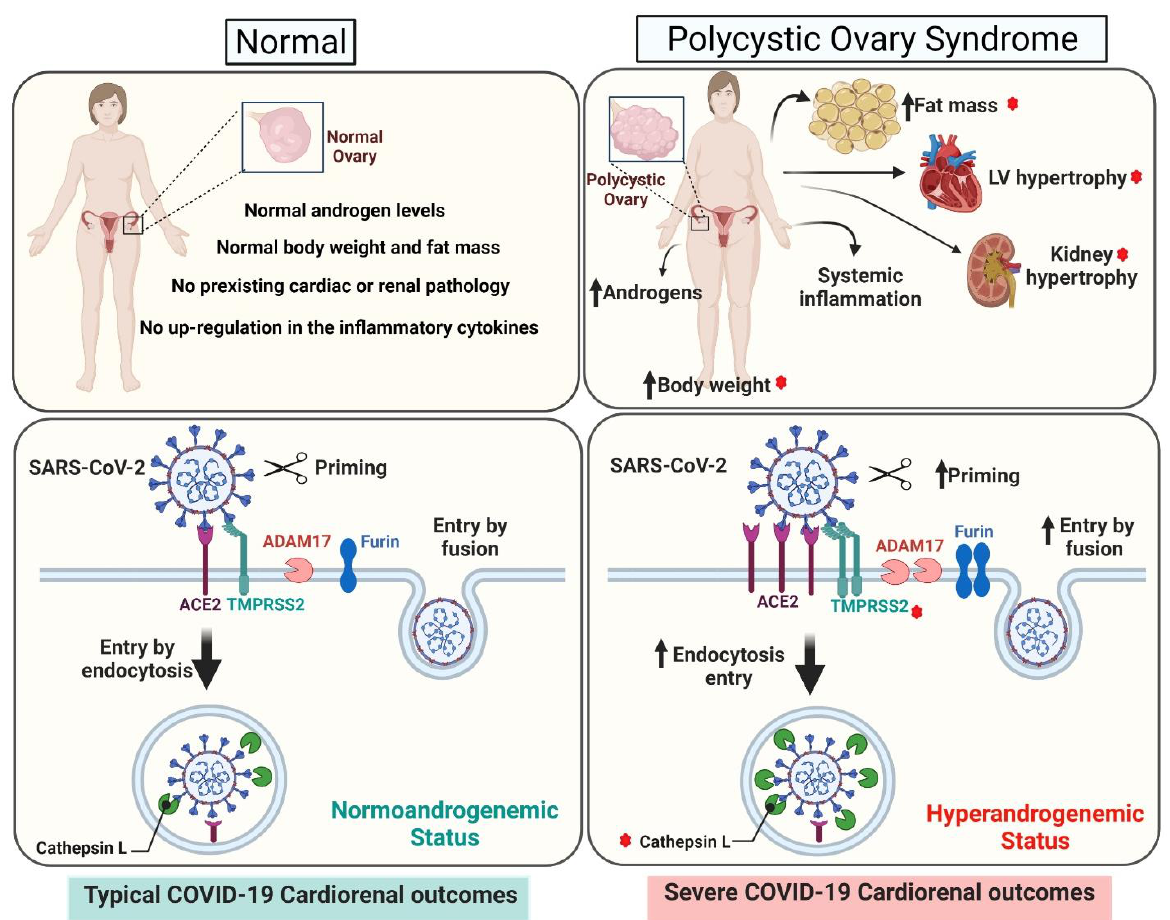
Figure 7. Proposed mechanisms for increased risk for severe COVID-19 cardiorenal outcomes in normal women and women with PCOS. Top panels: Women with PCOS have increased body weight, fat mass, and cardiac and renal hypertrophy. Lower panels: Androgens differentially regulate the cardiac and renal expression of SARS-CoV-2 viral entry proteins including the SARS-CoV-2 receptor ACE2 and several cellular proteases that promote viral entry and propagation. HFD exacerbates androgens-mediated obesity and cardiorenal hypertrophic response and modulates androgens’ effect on the expression of the different cellular proteases. The red stars indicates the parameters that are exacerbated with HFD.